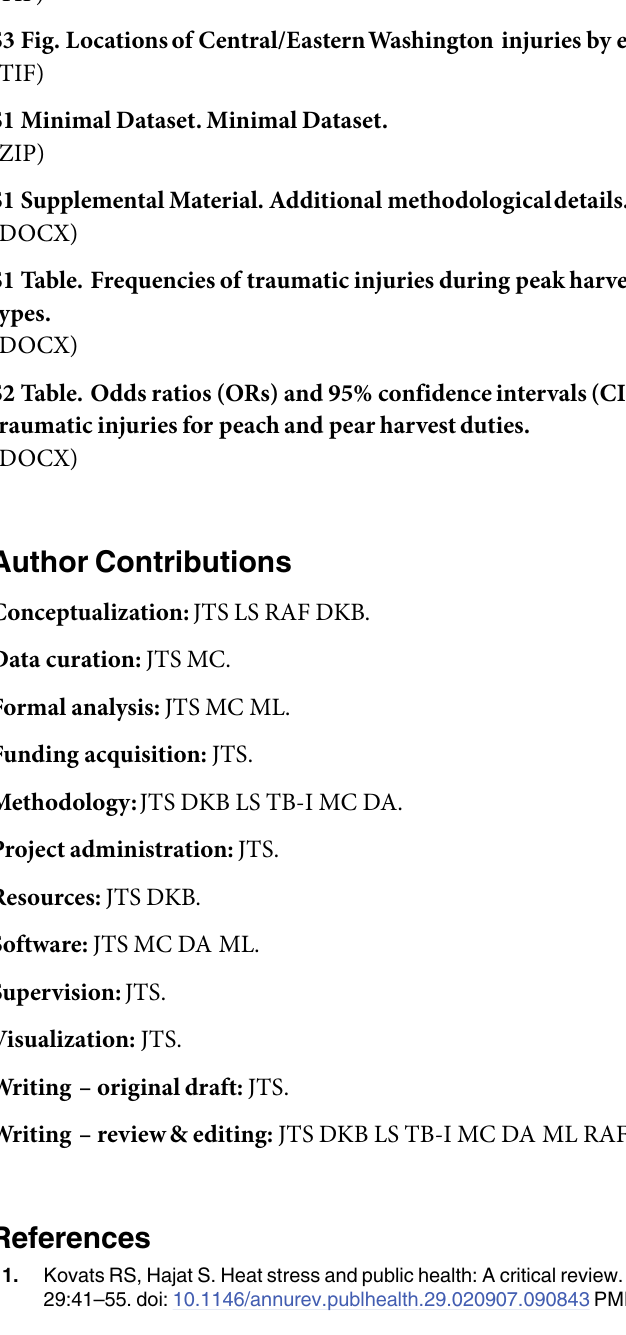
S1 Table. Frequencies of traumatic injuries during peak harvestmonths by harvestduty types. S2 Table. Odds ratios (ORs) and 95% confidence intervals (CIs) of workers’ compensation traumatic injuries for peach and pear